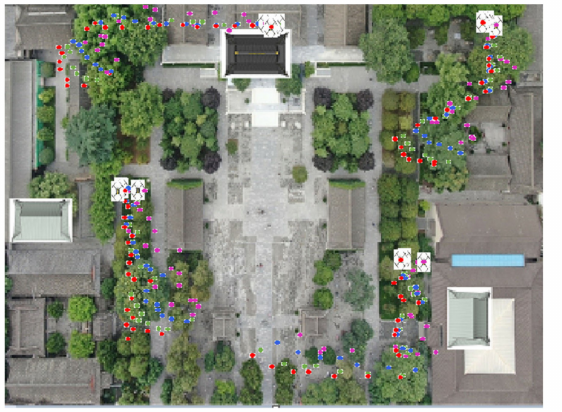
Figure 11. UAV trajectory (experimental occlusion scenario).